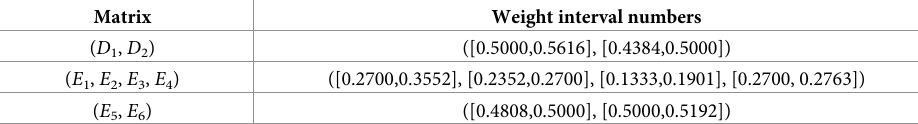
Table 13. Weight interval number of dynamic competency evaluation indices in reference [49].